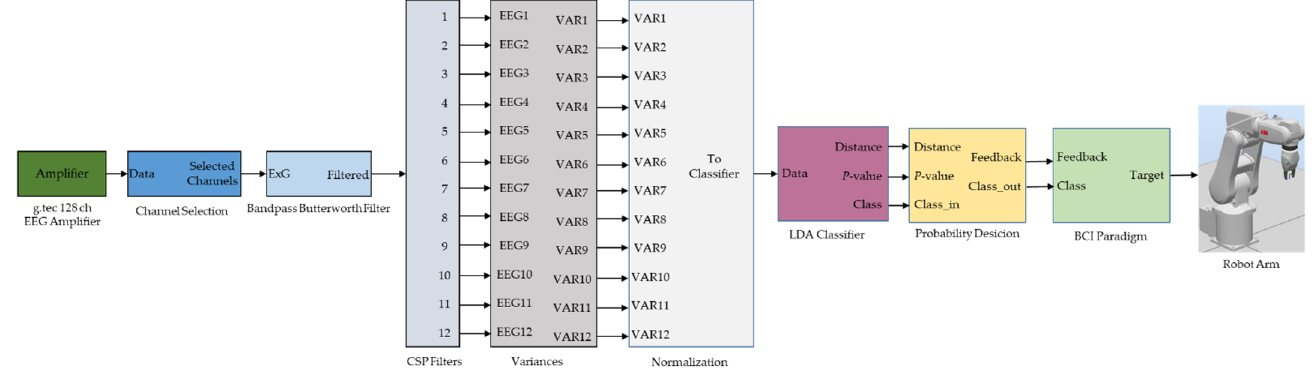
Figure 4. Motor imagery-based BCI model to control a robot arm.